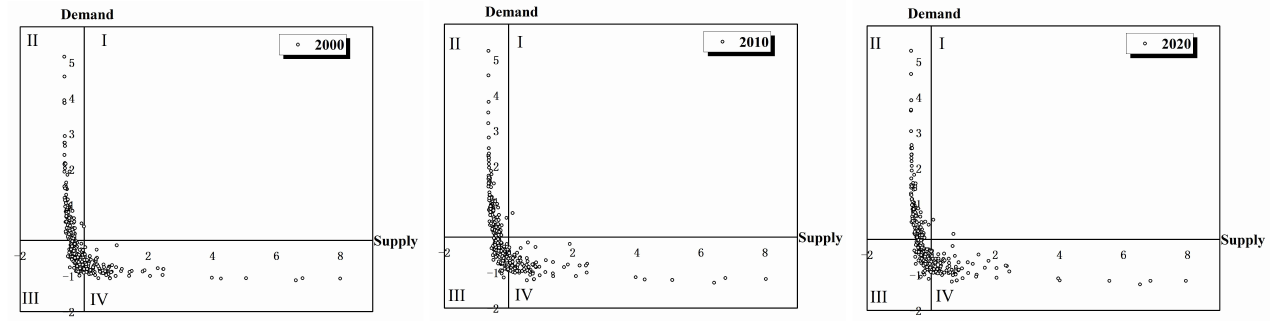
Figure 4. Correlation analysis of ES supply-demand in resource-based cities in the YRB from 2000 to